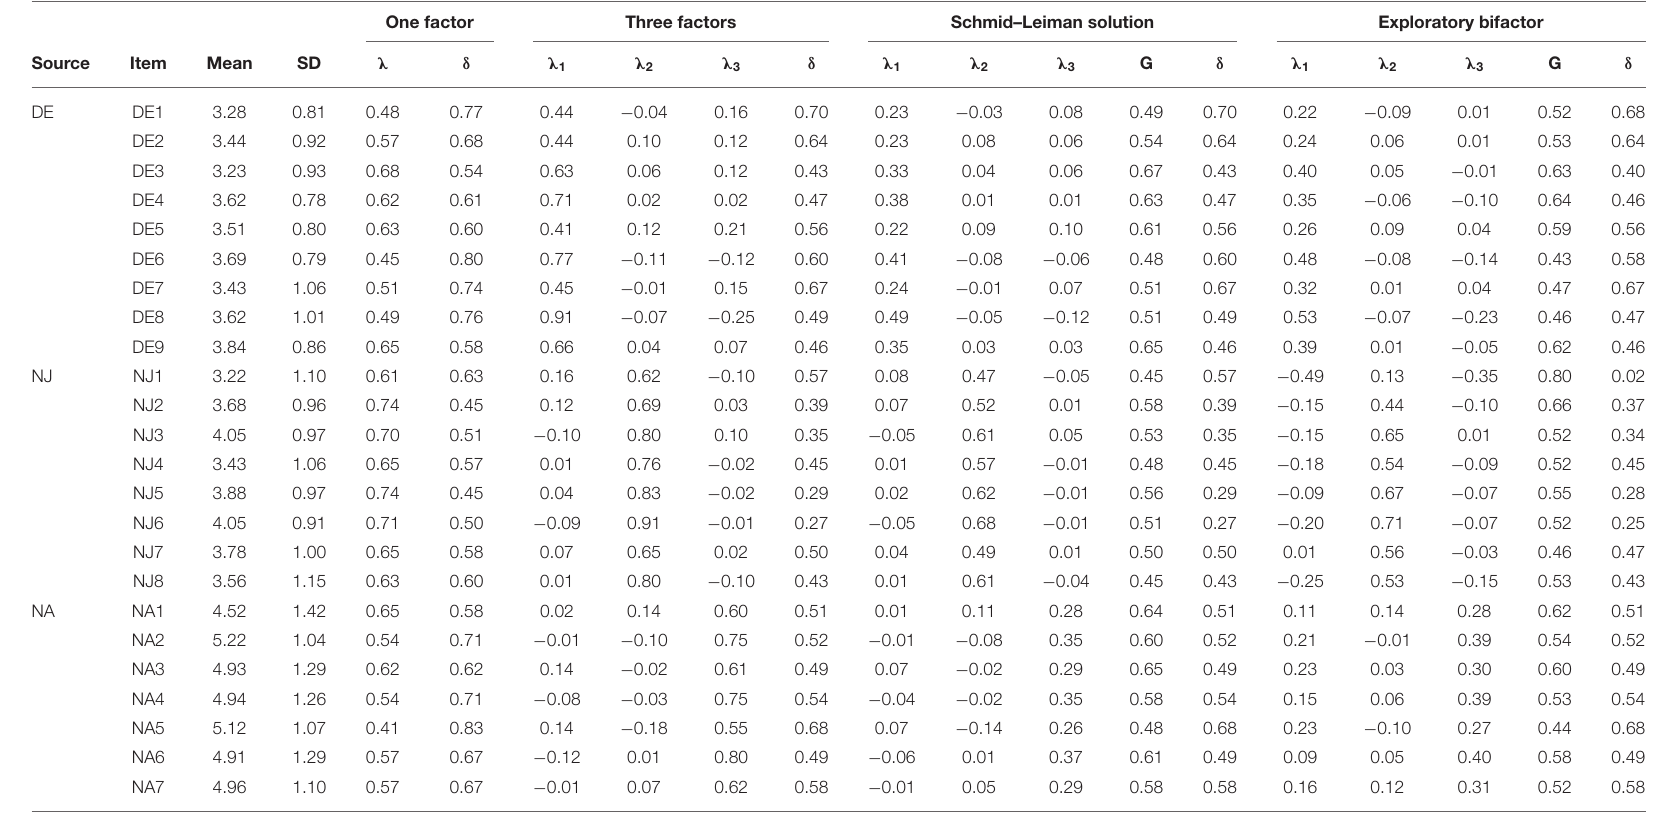
TABLE 2 | Descriptive statistics of the items and exploratory factor analyses (subsample